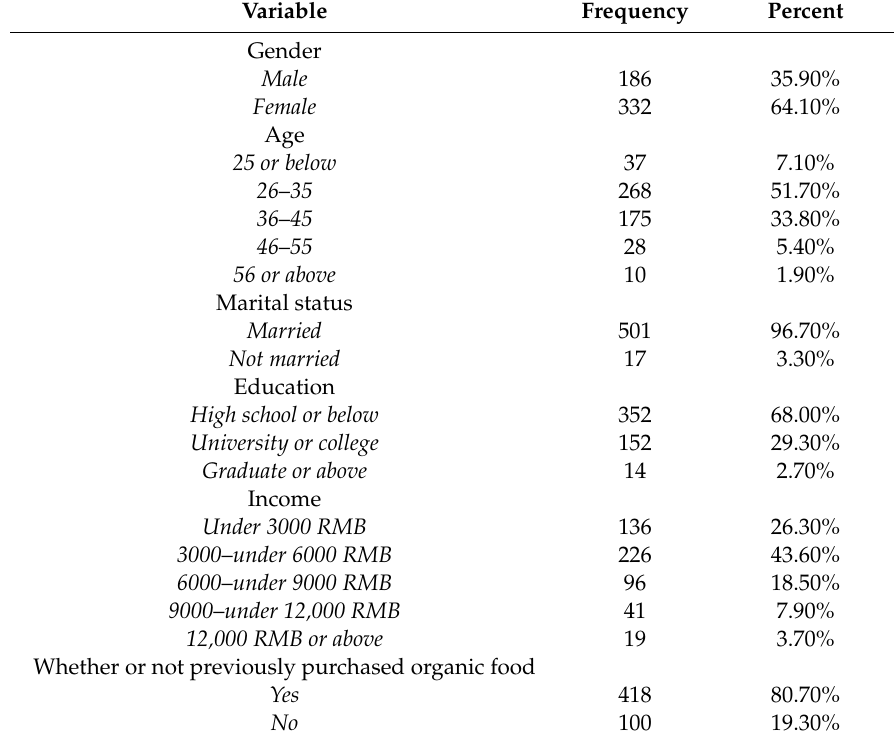
Table 1. Demographics of